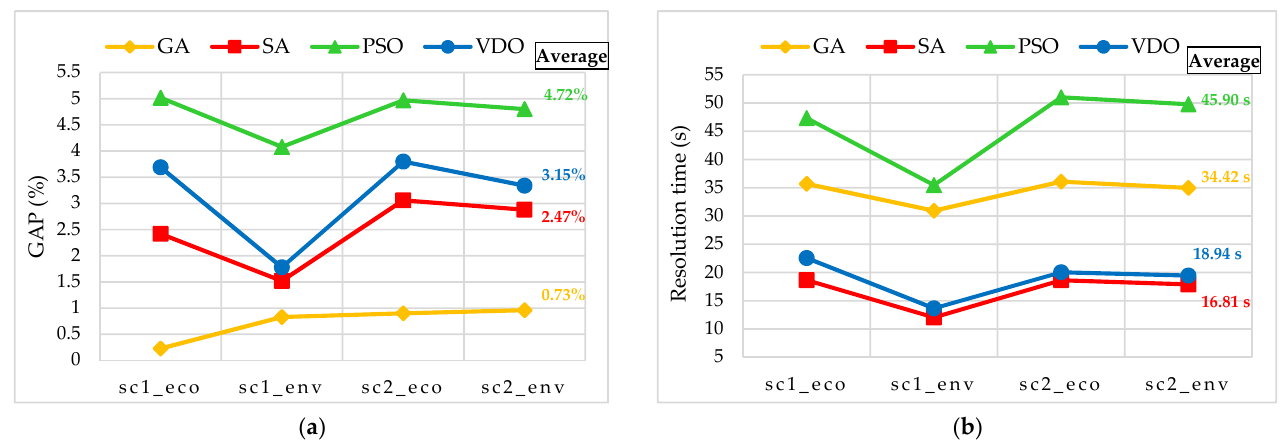
Figure 13. Performance results of the proposed algorithms. ( a ) Average GAP values; ( b ) average execution time values.